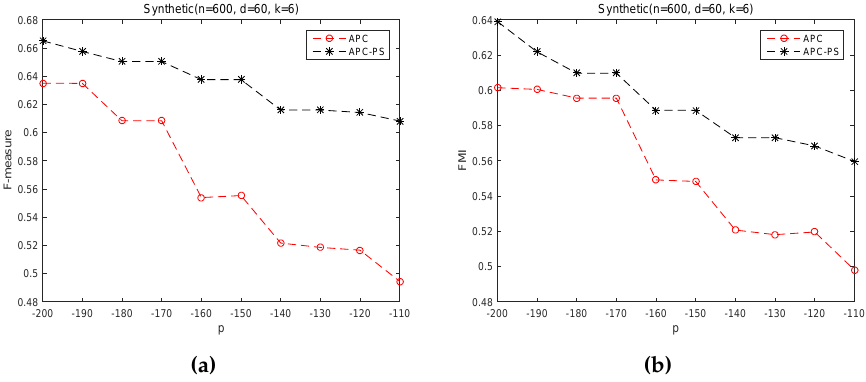
Figure 4. APC and APC-PS on Synthetic control chart dataset under different values of p . ( a ) F-measure; ( b )